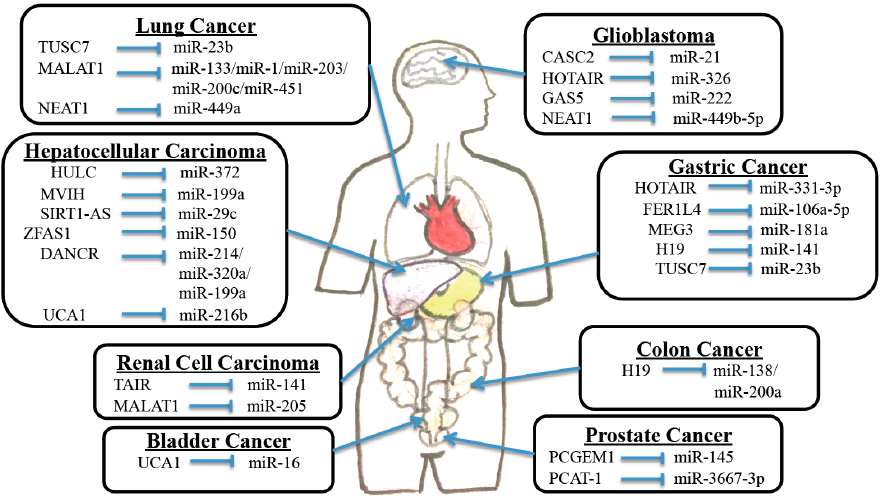
Figure 1. The crosstalk between lncRNAs and miRs in cancers.